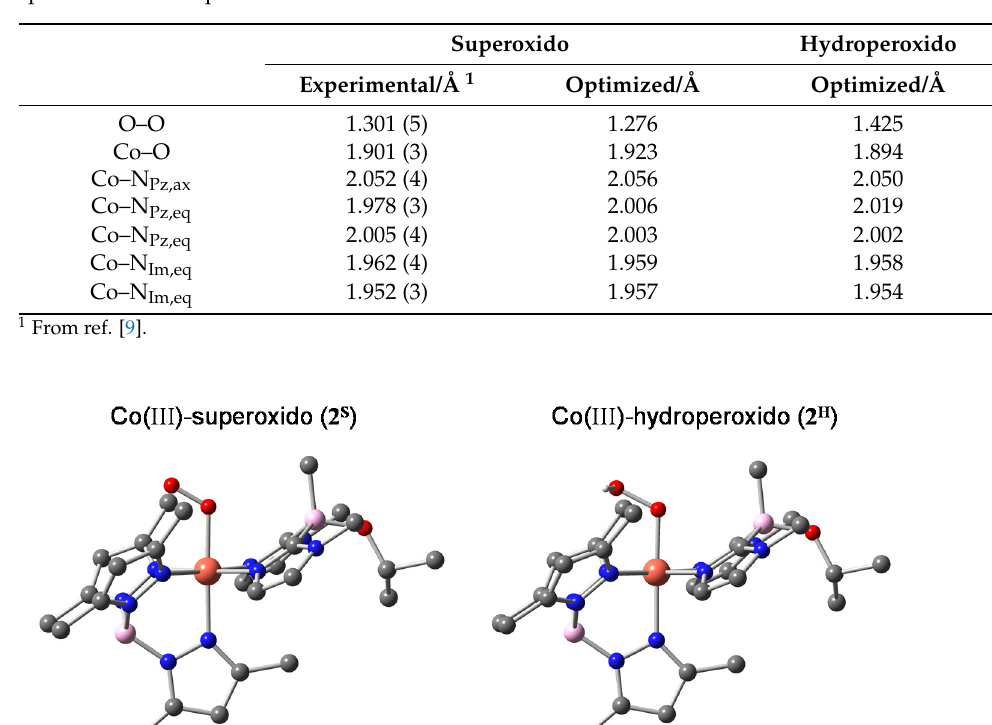
Table 2. Selected bond lengths (Å) of the optimized structures of the superoxido and hydroperoxido species with the experimental data of 2 S .